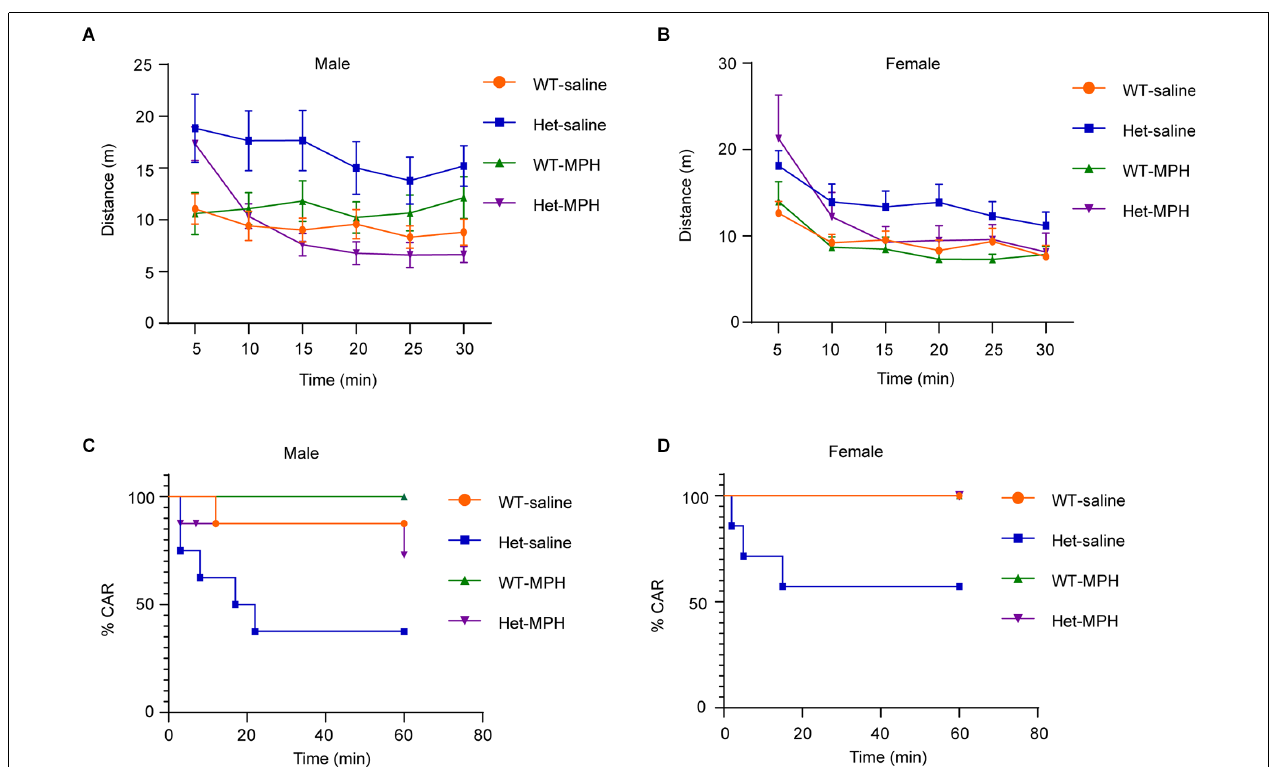
FIGURE 6 | Methylphenidate ameliorates both locomotor hyperactivity and impulsivity in heterozygous Kdm6b knockout mice. (A,B) The plots showing the running distances of male (A) and female (B) wild-type and heterozygous Kdm6b -KO mice treated with saline or methylphenidate (MPH) in a 5-min period for 30 min in the open-field chamber. For each treatment, n = 8 males and 7 females per genotypes. P-value calculated using two-way ANOVA test and Sidak’s multiple comparisons test. The interactive effects of genotype and treatment on running distances: male: F 3,168 = 19.65, p < 0.0001; female: F 3,144 = 8.154, p < 0.0001. Post-hoc test: WT-saline vs. Het-saline: male: p < 0.0001; female: p = 0.0007. WT-MPH vs. Het-MPH: male: p = 0.4; female: p = 0.12. Error bars in graphs represent mean ± SEM. (C,D) Graphs represent the time course of CAR measurement in male (C) and female (D) wild-type and heterozygous Kdm6b -cKO mice treated with saline or MPH in a 60-min CAR testing period. For each treatment, n = 8 males and 7 females per genotypes. P-values calculated using a Log-rank (Mantel-Cox) test.The effects of genotype and treatment on CAR, male: Chi square = 10.34, df = 3, p = 0.016; female: Chi square = 10.58, df = 3, p = 0.014. The effects of genotype in response to treatments, WT-saline vs. Het-saline, male: p = 0.0436; female: p = 0.048; WT-MPH vs. Het-MPH, male: p = 0.13; female: p =